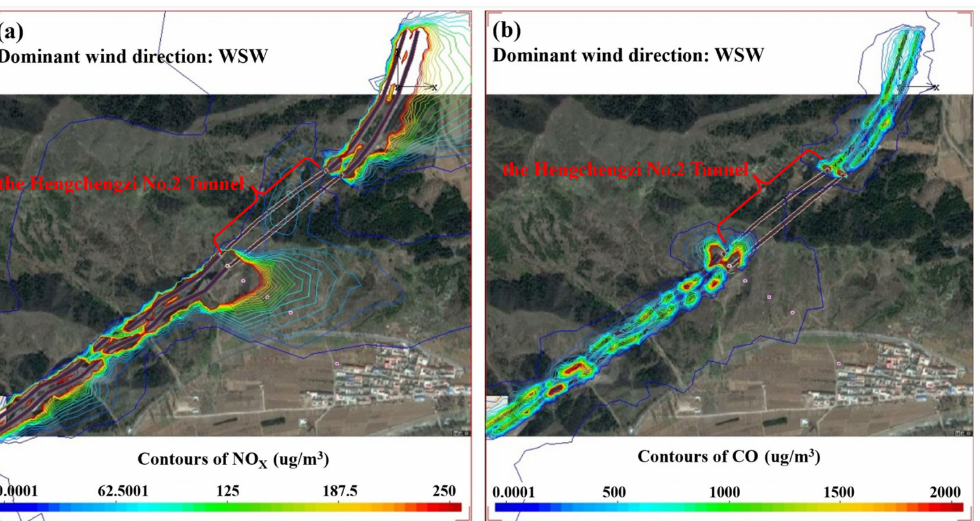
Figure 17. Concentration distribution of NO X and CO in the Hengchengzi No. 2 Tunnel section. ( a ) NO X ; ( b )